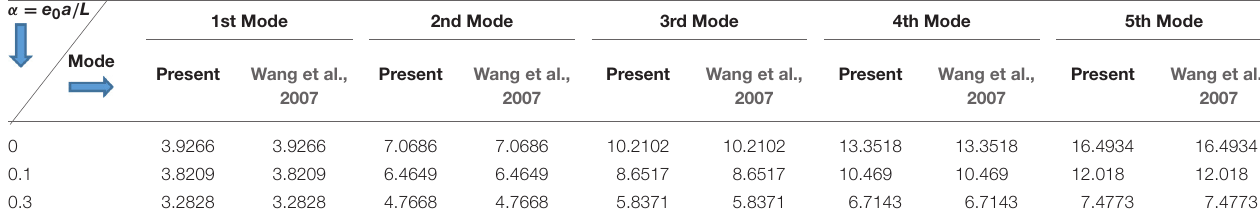
√ λ for CS case. (cid:16) (cid:17)